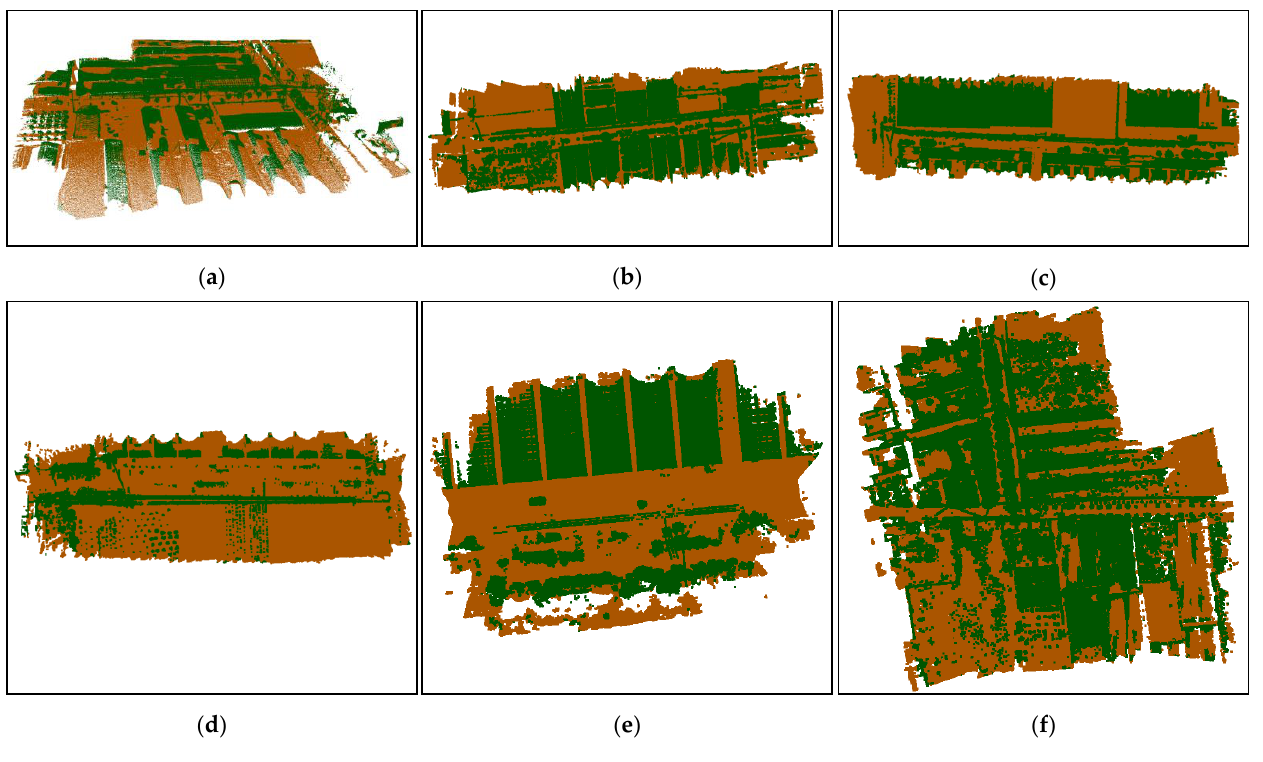
Figure 9. Non-ground points (green point) and ground points (brown point). ( a ) Dataset-I. ( b ) Dataset-II. ( c ) Dataset-III. ( d ) Dataset-IV. ( e ) Dataset-V. ( f ) Dataset-VI.